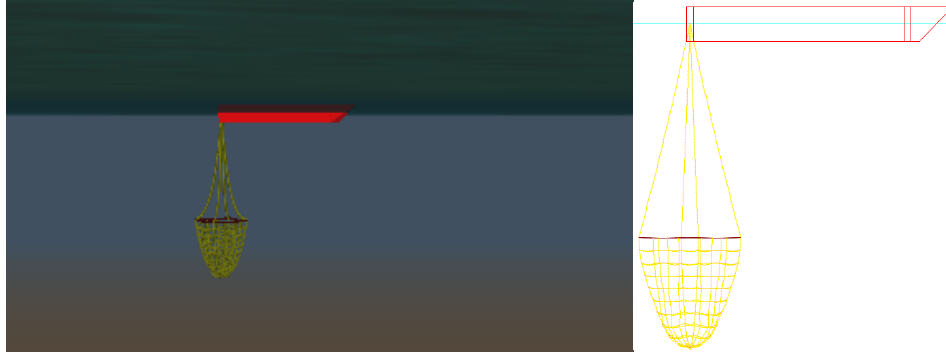
Figure 5. The rigid truss trawl system in OrcaFlex.